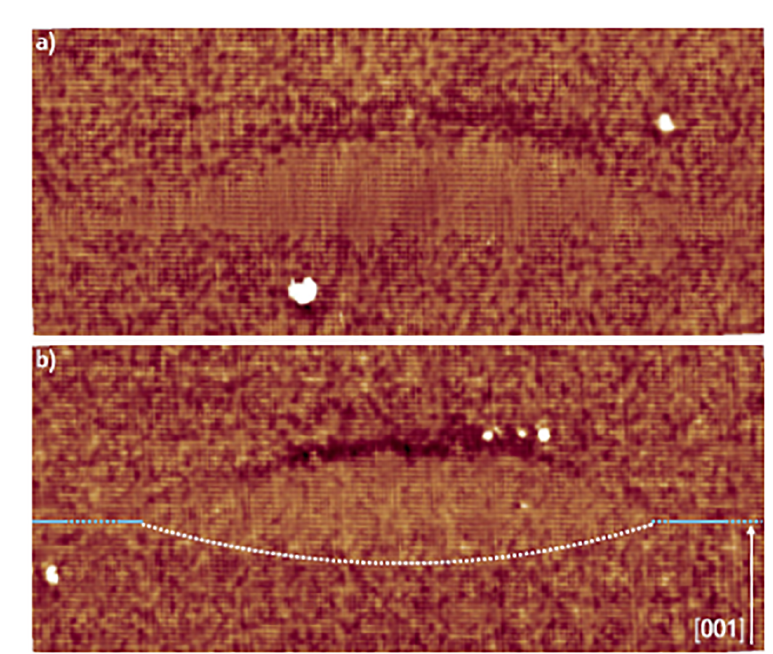
Figure 8. 32 × 76 nm 2 filled-state topography images of DE-QDs grown under the exact same conditions. Examples of QDs with ( a ) low and ( b ) high level of Al intermixing. The dotted line indicates roughly the bottom interface of the QD. Adopted from Ref.